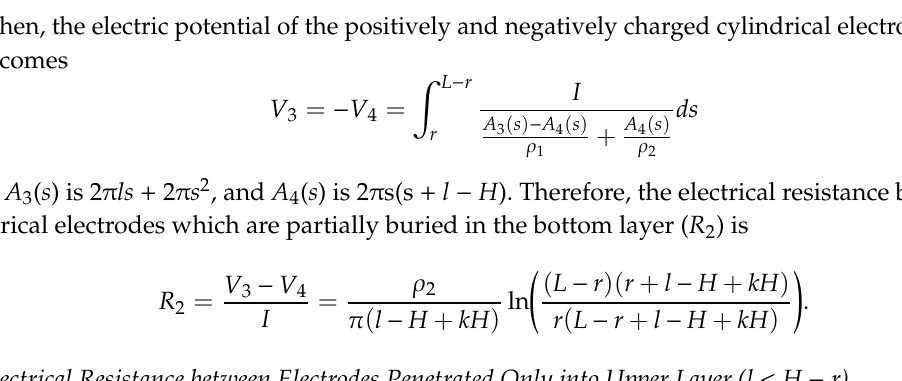
Figure 2. Definitions of the symbols used to represent two partially penetrated cylindrical electrodes embedded on two layers ( l < H < l + r